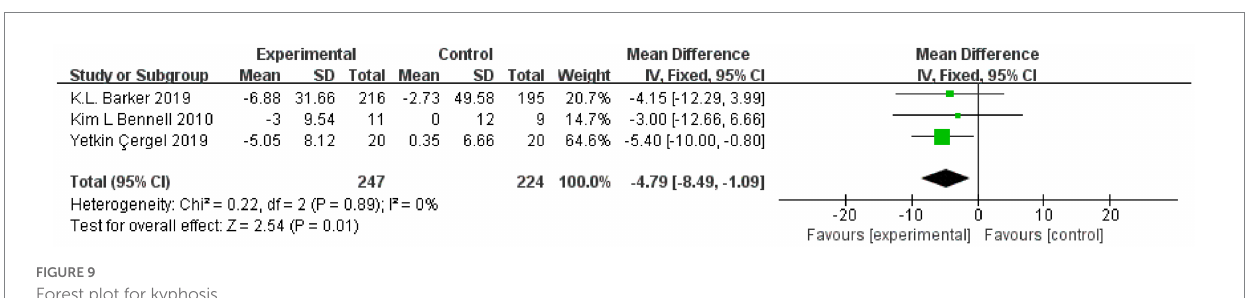
FIGURE 9 Forest plot for